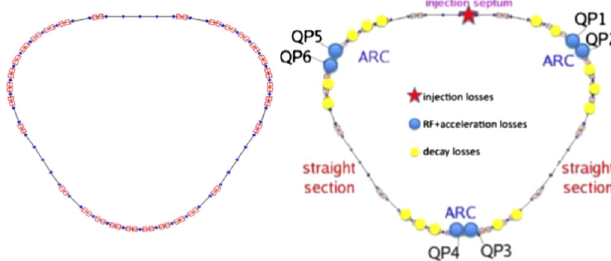
FIG. 33. Schematic layout the RCS, left, and the points where the highest losses are,